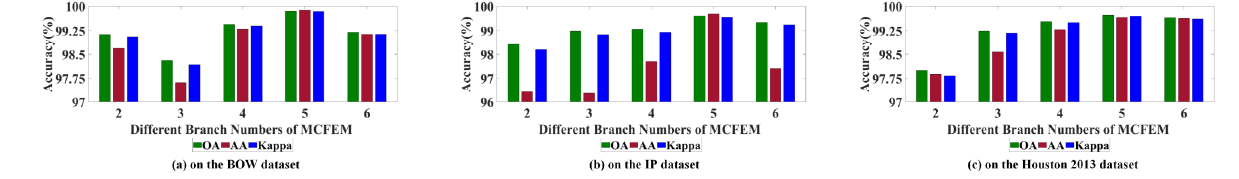
Figure 12. The classification results of various branch numbers.